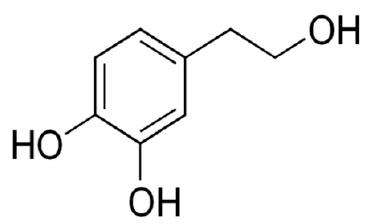
Figure 1. Chemical structure of hydroxytyrosol.